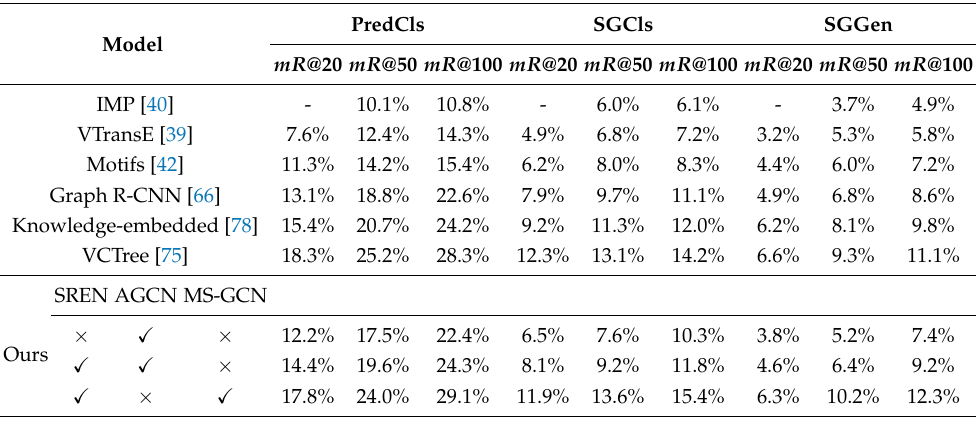
Table 2. Experimental results on VG [49] dataset.